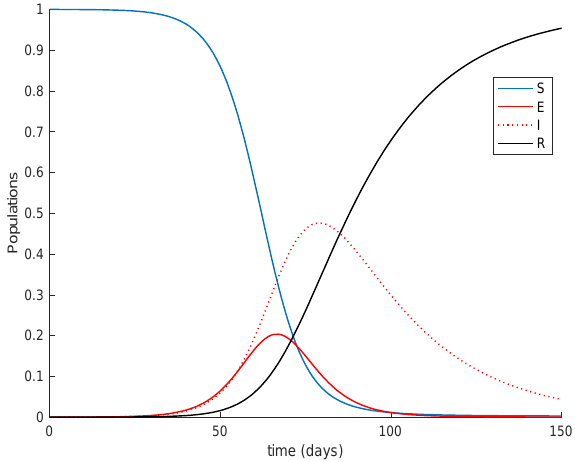
Figure 1. Dynamics of the model for COVID-19 pandemic.